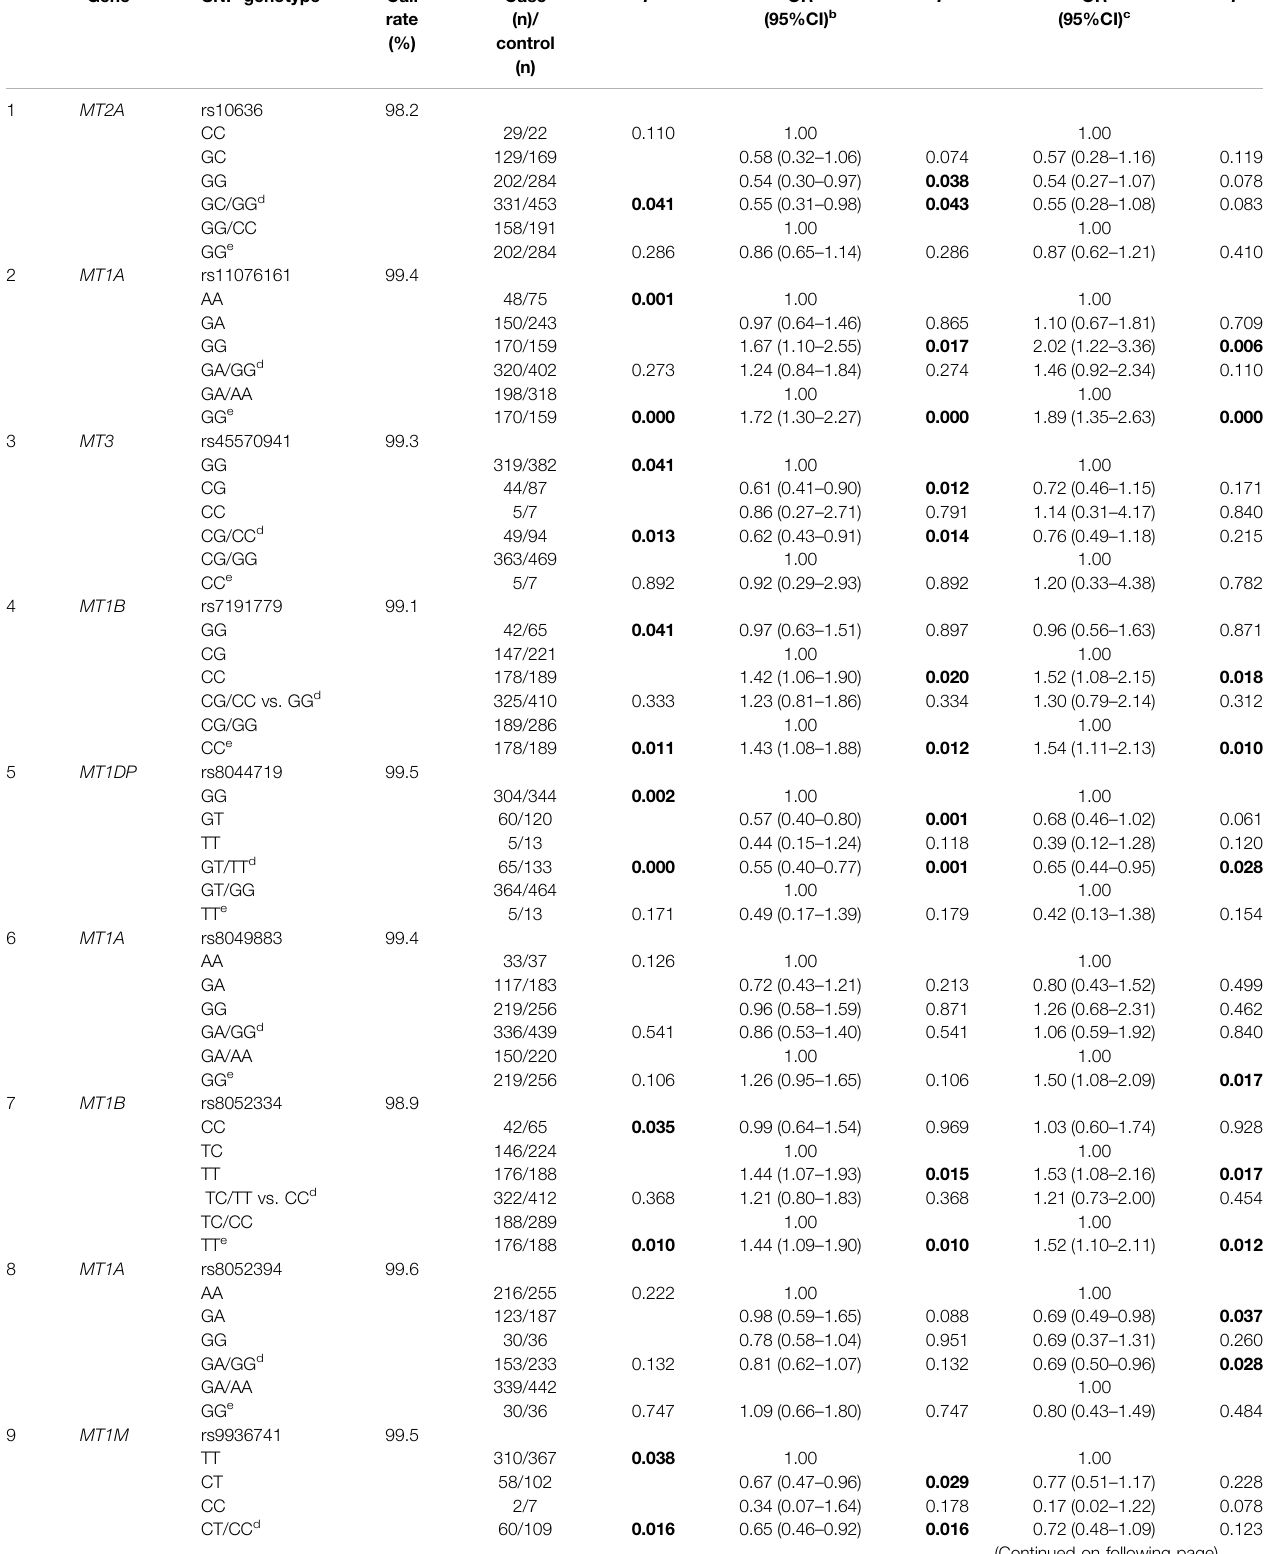
TABLE 3 | Association between assayed SNPs in MT genes and the susceptibility of HDP.